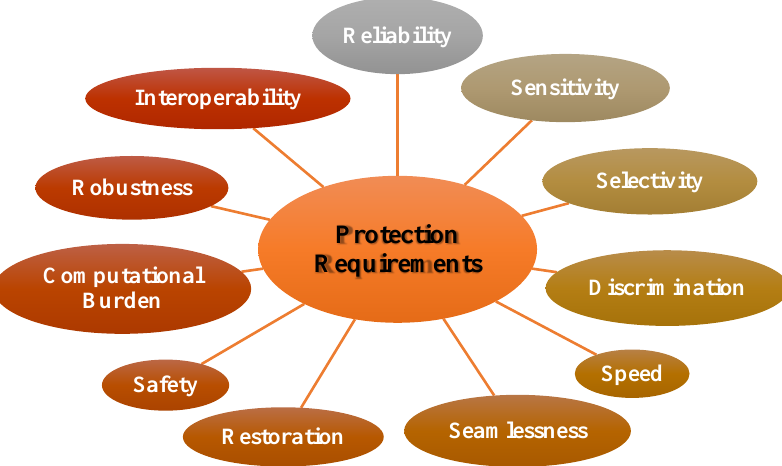
Figure 11. Protection requirements for HVDC